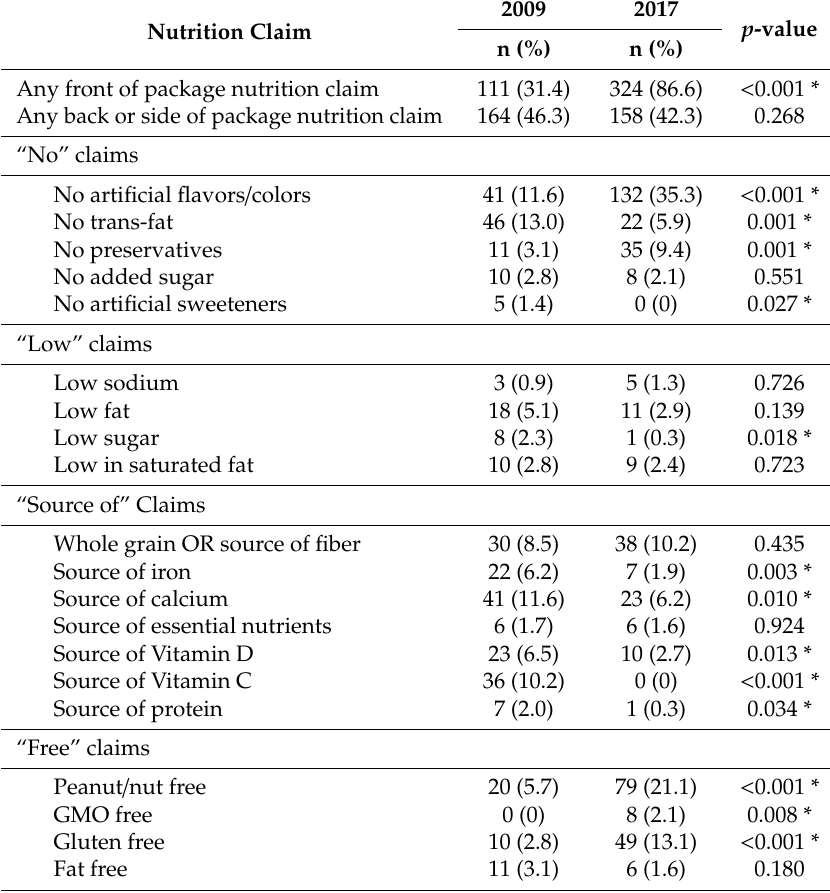
Table 4. Comparison of nutrition claims on children’s food products from 2009 and